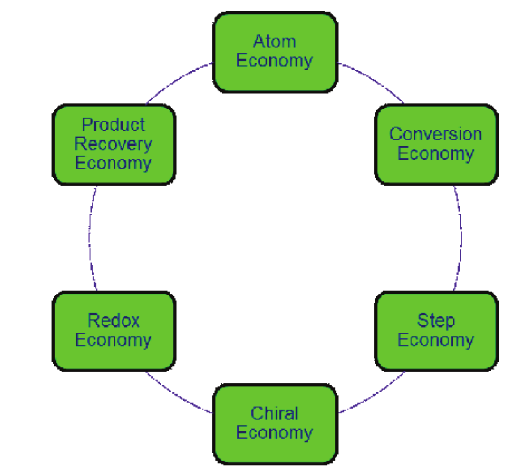
Fig. 1 – Manufacturing performance, selectivity, sustainabil- ity by molecular